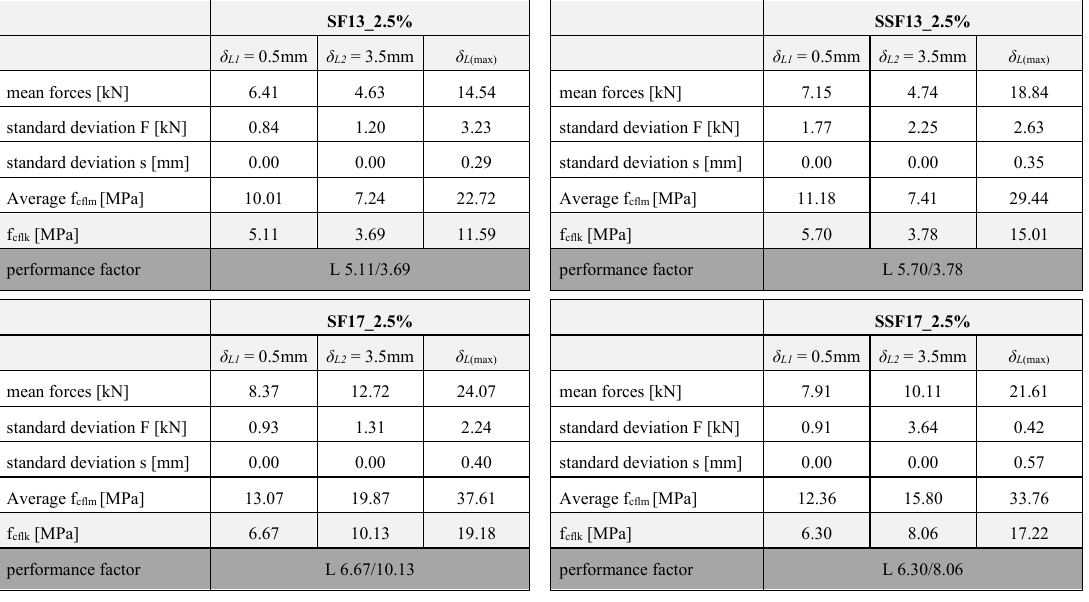
Figure 12. Influence of fibre material and length (at a constant volume fraction of 2.5 vol%) on the flexural strength. Data shown highlight the flexural load at a distance of 0.5 mm, 3.5 mm and the maximum load including standard deviations. Table 5. Results of the flexural strength of the fibre material and length (constant fibre volumes of 2.5 vol%) and classification into performance classes.